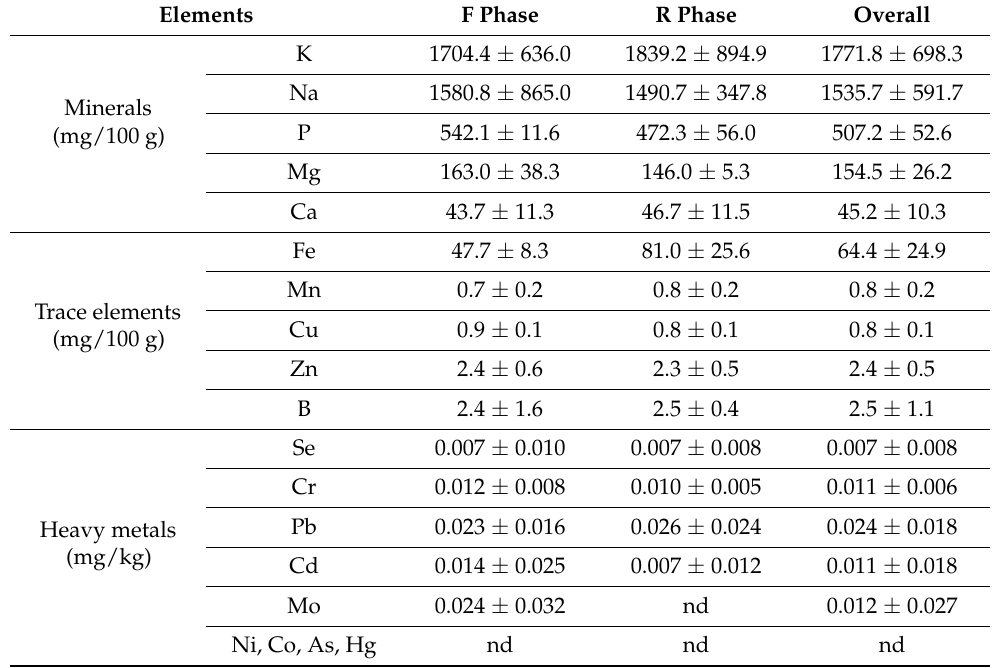
Table 3. Mineral composition (in mg/100 g), trace metals (in mg/100 g) and heavy metal content (in mg/kg) in A. platensis BEA 1257B biomass samples collected during the first phase (F phase, 12 Sep. to 11 Oct., samples F1, F2 and F3) and during the second phase of the experiment (R phase, 11 Oct. to 11 Nov., samples R1, R2 and R3) from the 8000 L raceway pond inside greenhouse. Overall content in the biomass is also reported. Data are presented as the mean ± SD of three samples for F and R phase, and as the mean ± SD of six samples